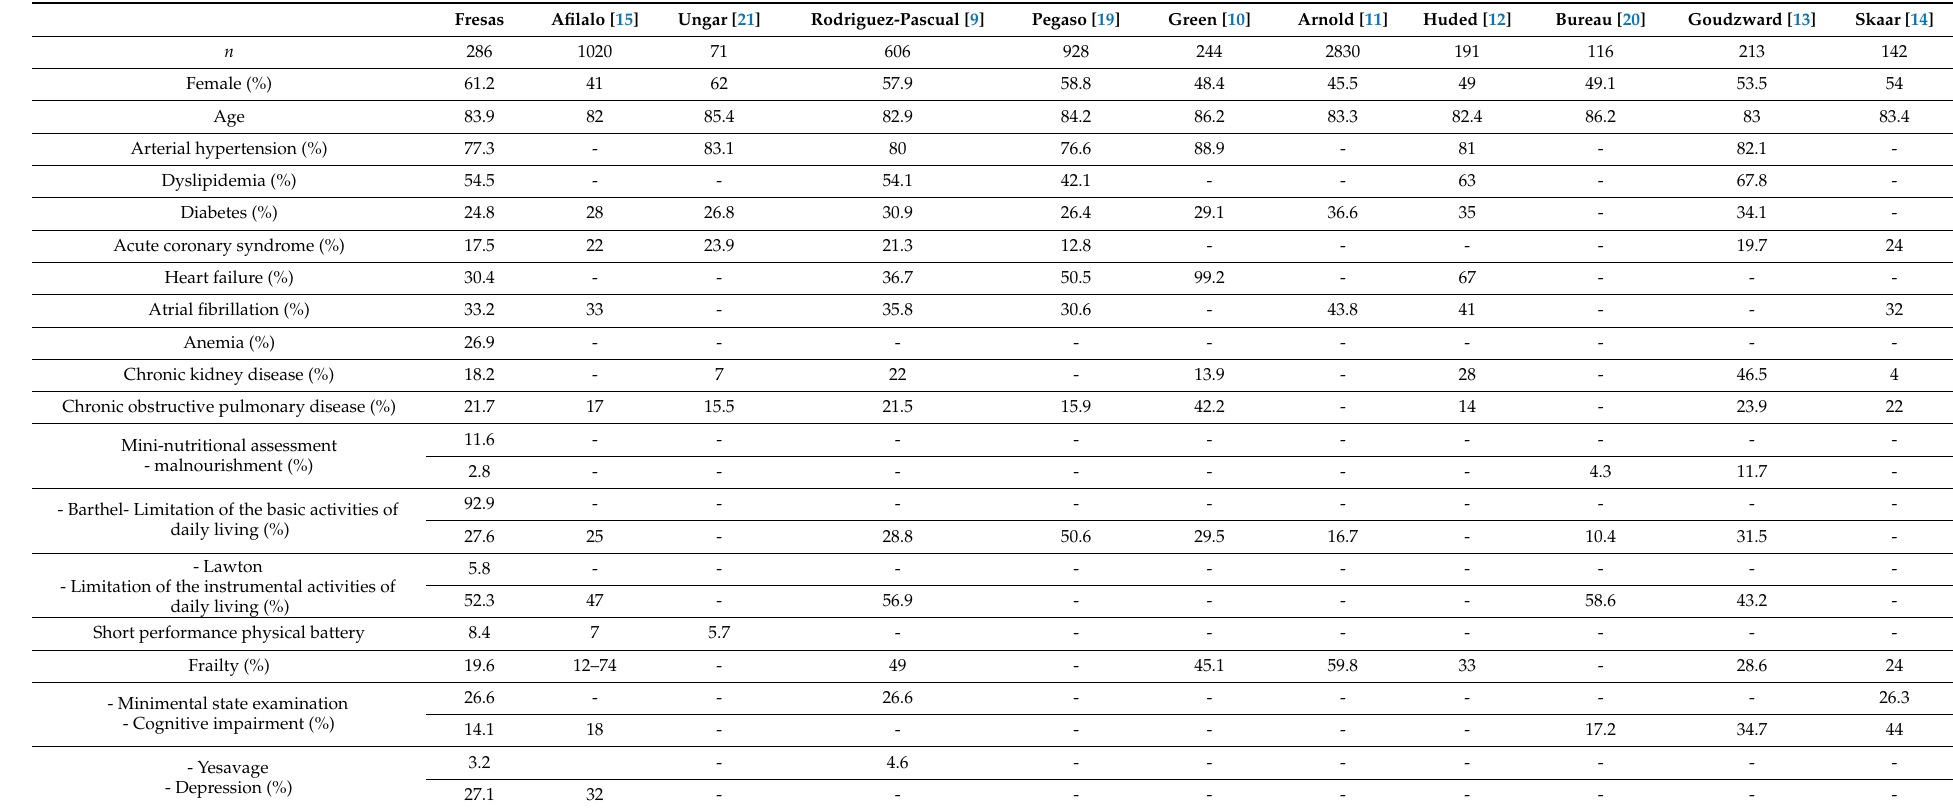
Table 4. Baseline characteristics and prevalence of frailty among different